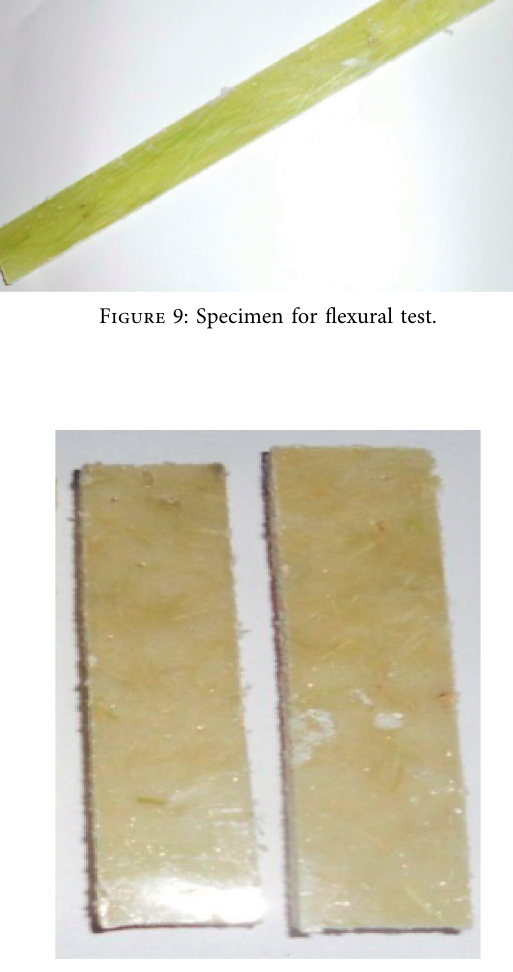
Figure 10: Specimen for impact test. Table 4: Tensile test